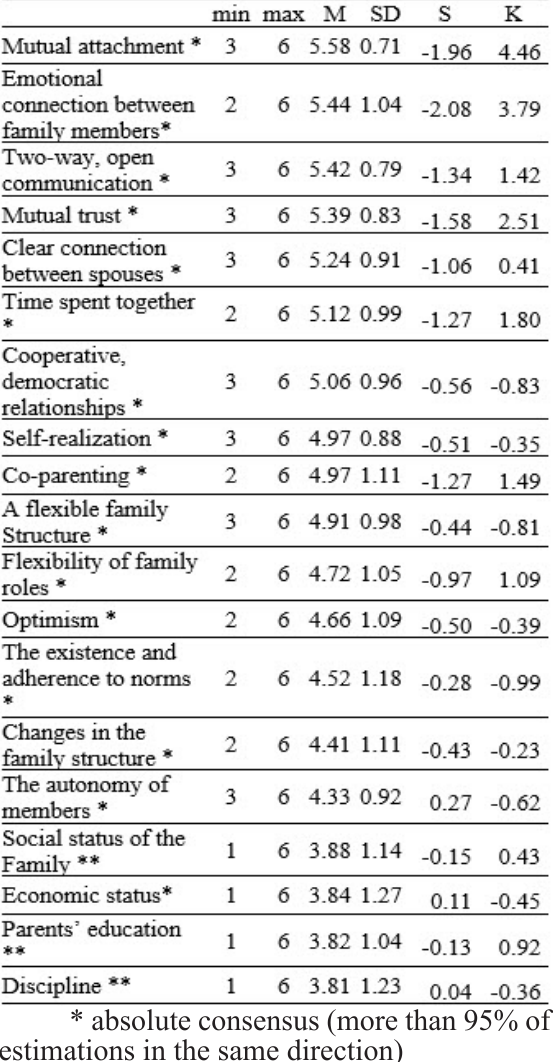
Table 2. The estimation of significance of family relationships and the family functioning quality status (for the whole